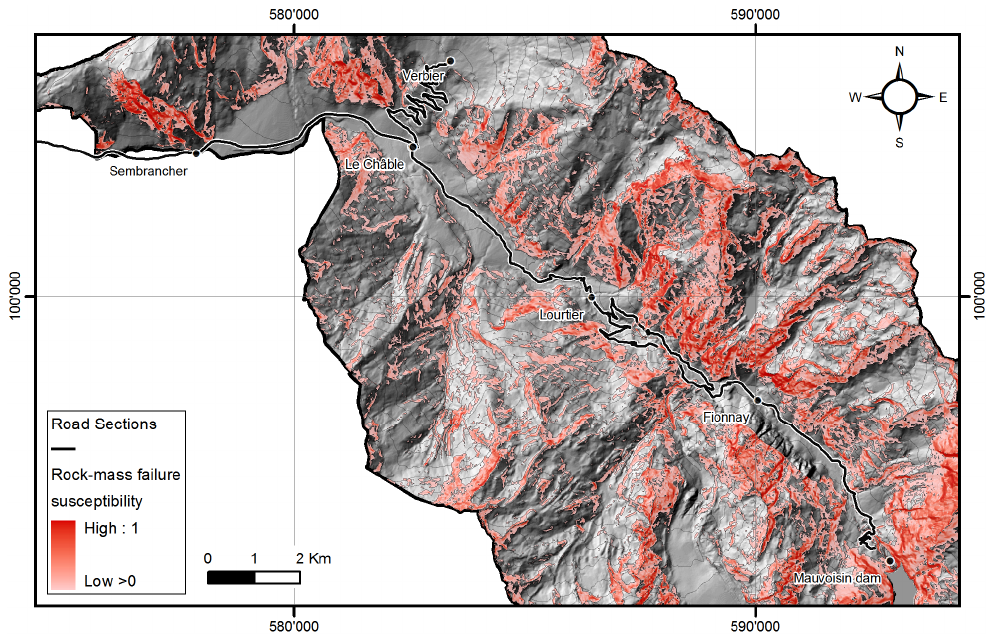
Fig. 7. Rock-mass failure susceptibility in the Bagnes Valley, identified thanks to the improved Slope Angle Distribution approach. (Hillshade and 10m isohypses: © 2008 swisstopo)